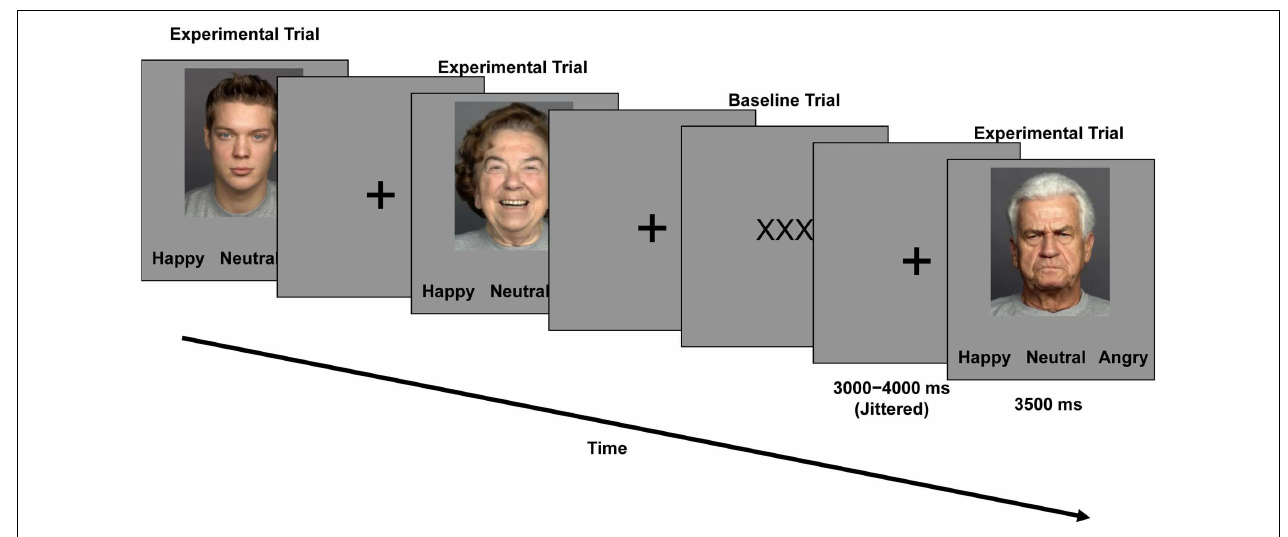
FIGURE 1 |Trial event timing and sample faces used in the Facial Expression IdentificationTask .